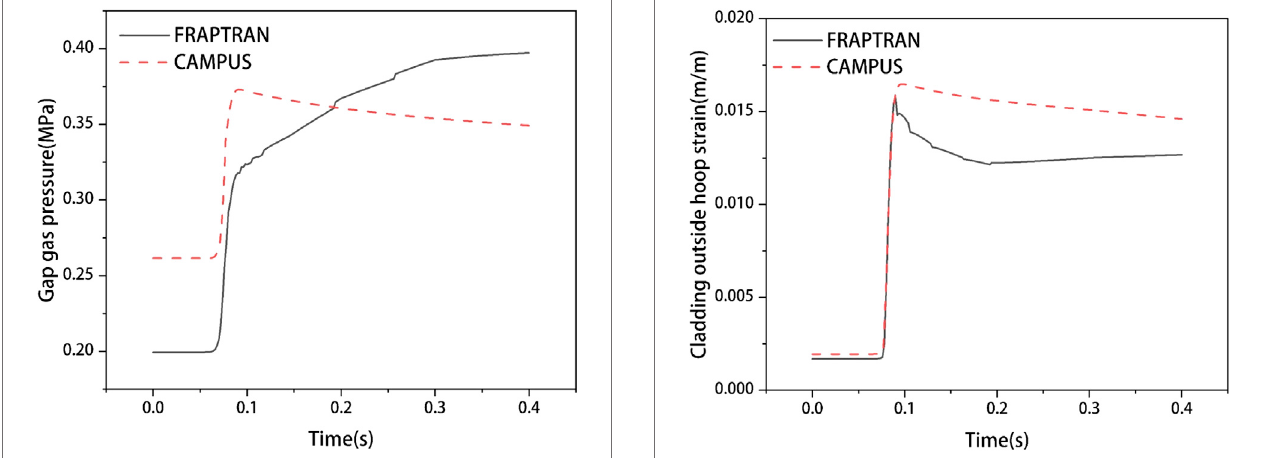
FIGURE 8 | Plenum pressure evolutions of the UO 2 fuel with Zircaloy cladding calculated by the FRAPTRAN and CAMPUS codes under the RIA condition.